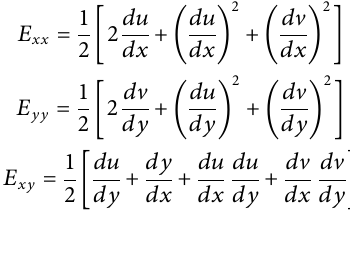
Frontiers in Materials |